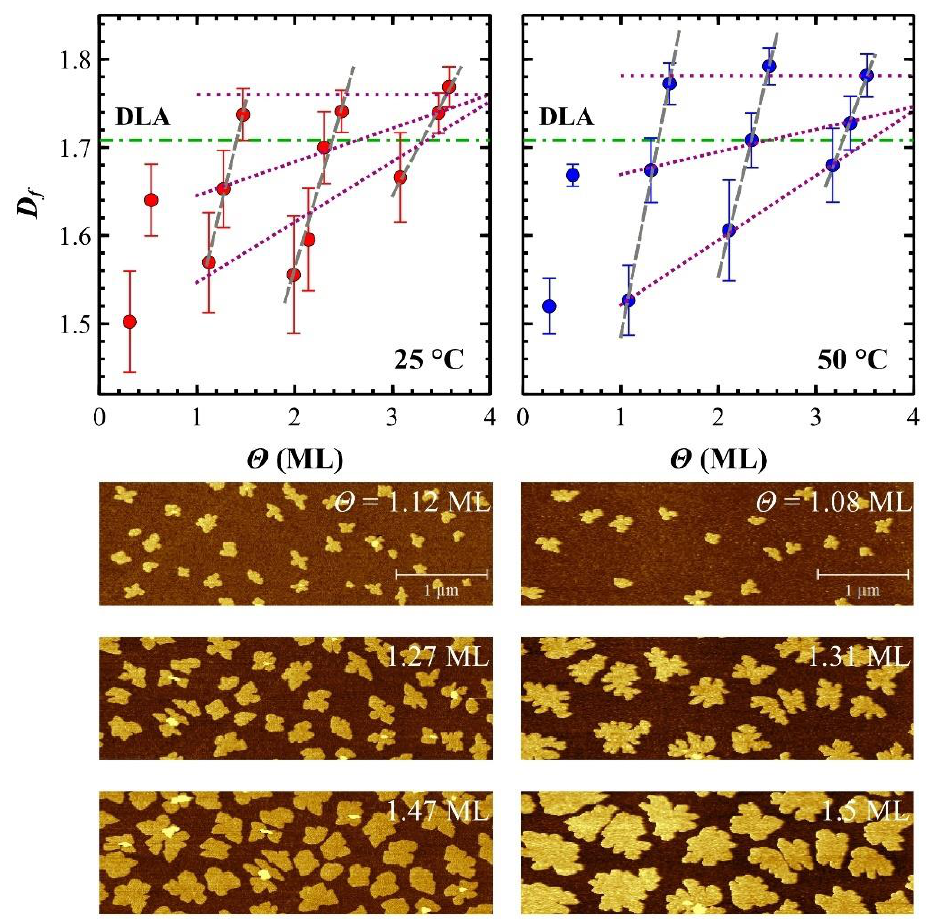
Figure 4. Fractal dimension plots for 25 ◦ C ( left ) and 50 ◦ C ( right ) referred to the DLA limit (dashed- dot lines). Illustrative examples of in situ AFM images for increasing partial coverage Θ p below the aggregation regime ( Θ p < n + 0.5 where n = 0, 1, 2, and 3) for 25 ◦ C ( left ) and 50 ◦ C ( right ).